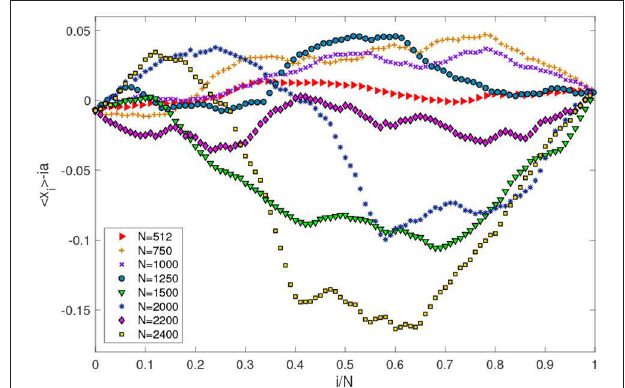
FIGURE 4 | Equilibrium simulations. Plot of the displacement of the mean position of particle i from its mechanical equilibrium position, various values of N , for first and second neighbors interactions when T L T R 5. The deviations from the mechanical equilibrium are negligible. = =